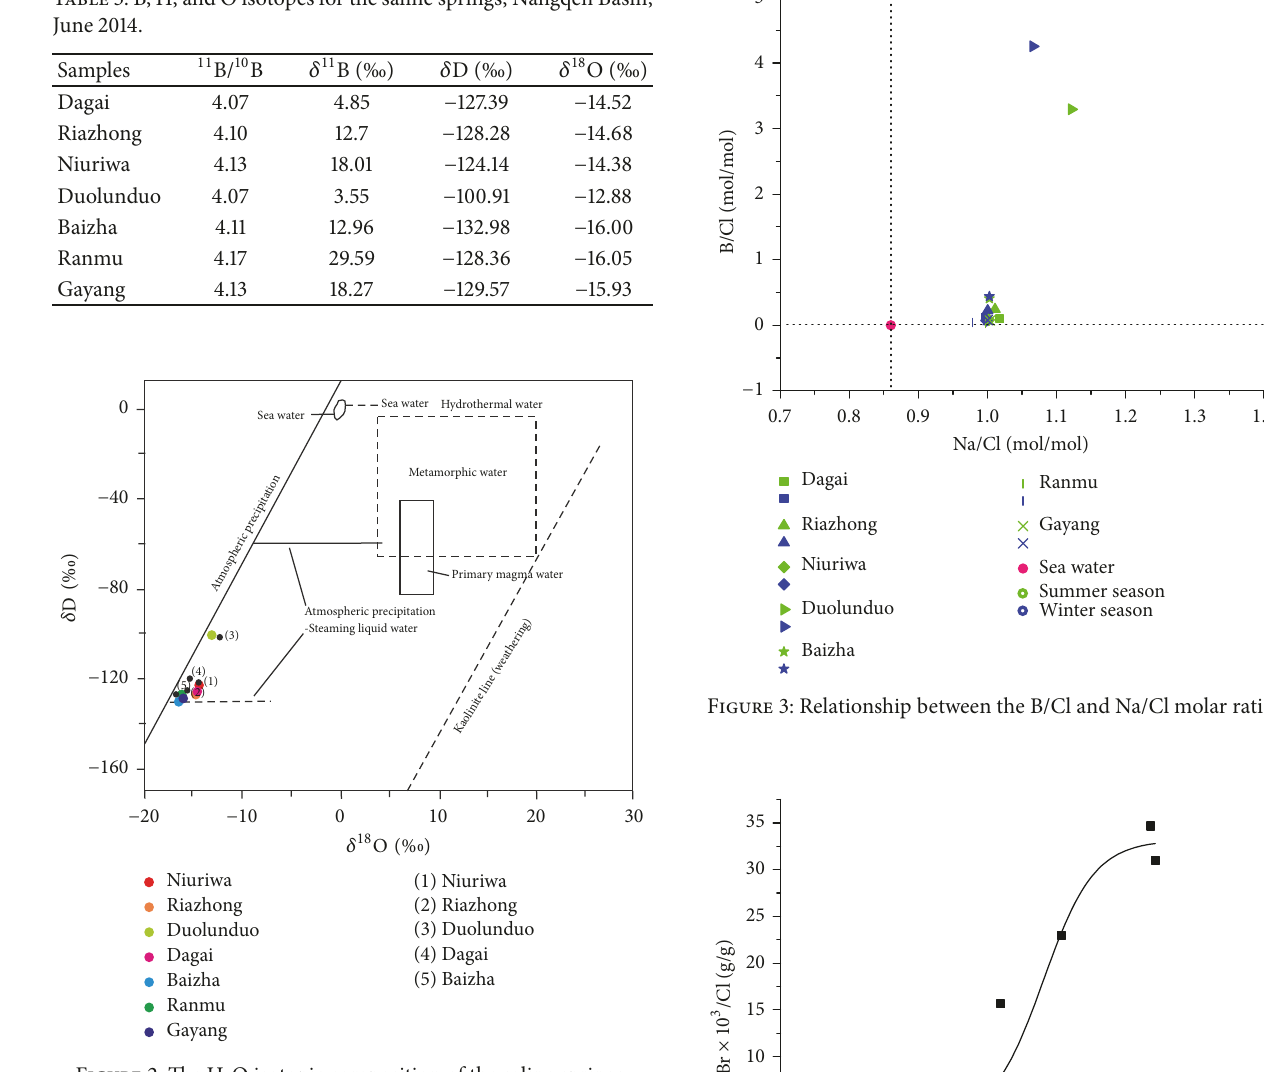
samples have B/Cl values away from the marine line (Na/Cl −4 ) [27]. = 0.86; B/Cl = 7 × 10